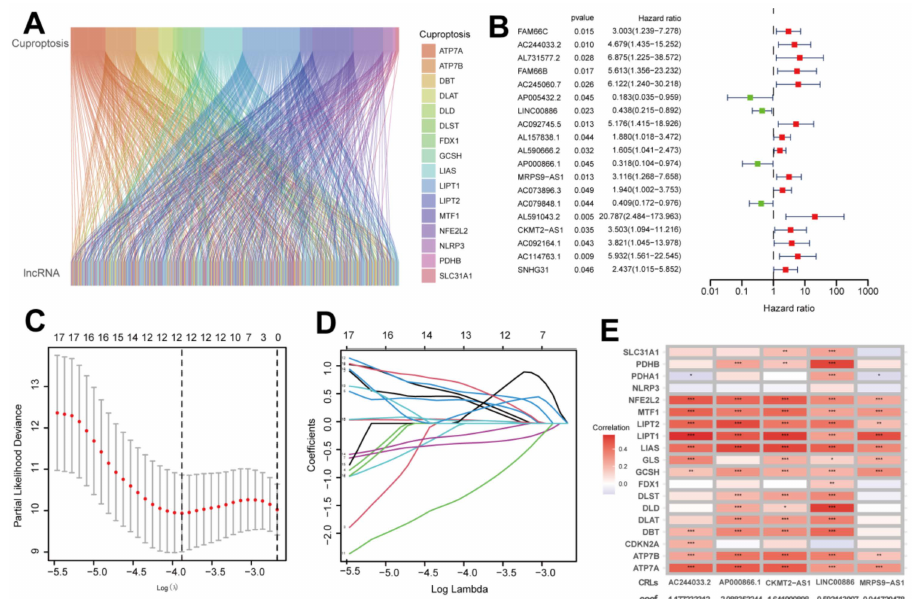
Figure 2. Identifying the prognostic features of papillary renal cell carcinoma (pRCC) linked to cuproptosis-related lncRNAs (CRLs). ( A ) The sankey relation between cuproptosis genes and CRLs. ( B ) Forest map showing prognostic genes for CRLs. ( C ) Least absolute shrinkage and selection operator (LASSO) coefficients of CRLs. ( D ) Cross-validation of CRLs in the LASSO regression. ( E ) Multivariate Cox regression and correlation for cuproptosis genes and CRLs. *, p < 0.05; **, p < 0.01; ***, p <